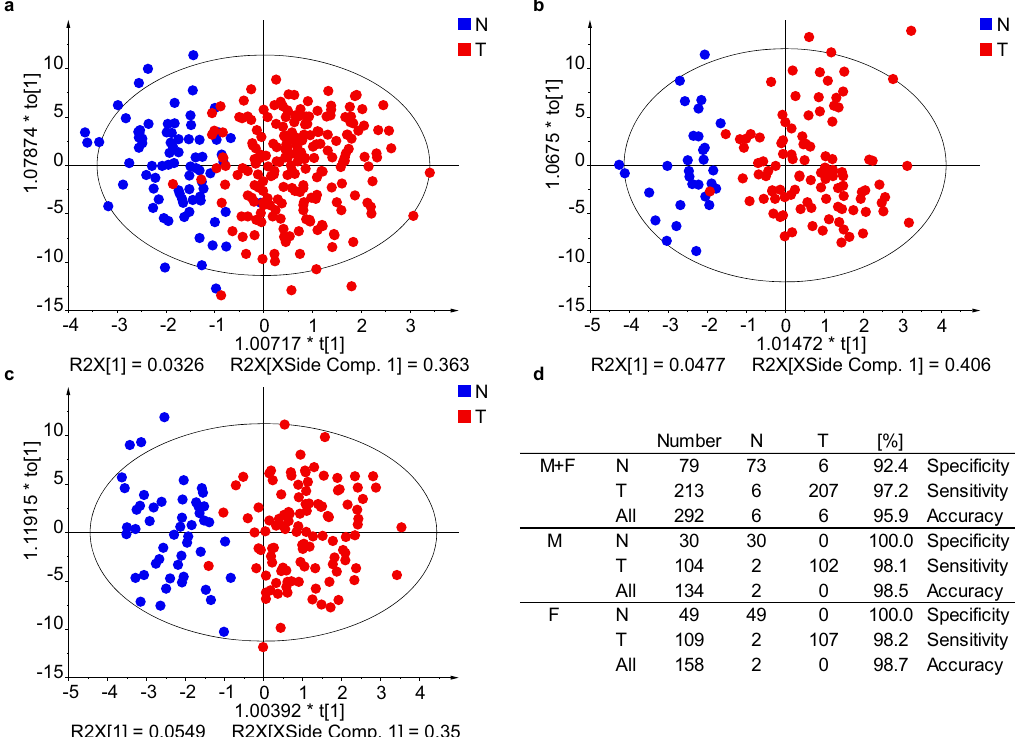
Fig. 2 Effect of gender separation on the quality of OPLS-DA models used for the differentiation of human serum samples obtained from PDAC patients (T) and healthy controls (N) for the training set using UHPSFC/MS in the Phase I. a Both genders. b Males. c Females. d Speci fi city, sensitivity, and accuracy for individual models. Source data are provided as a Source Data fi